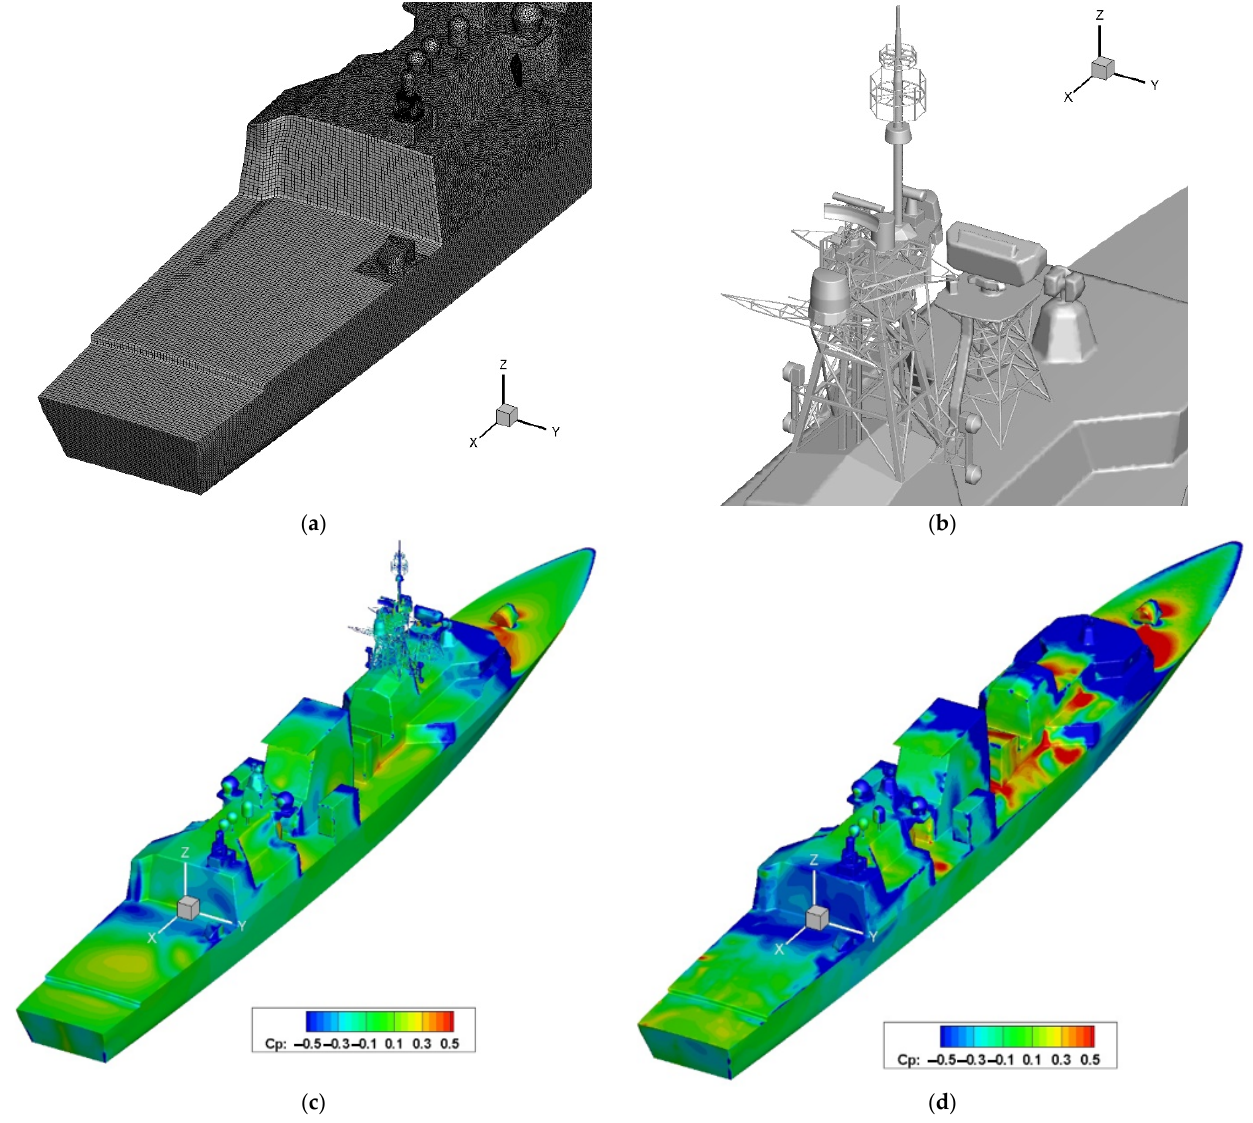
Figure 2. CPF models used in the present CFD study. ( a ) Surface meshes. ( b ) Masts. ( c ) With-masts model. ( d ) No-mast